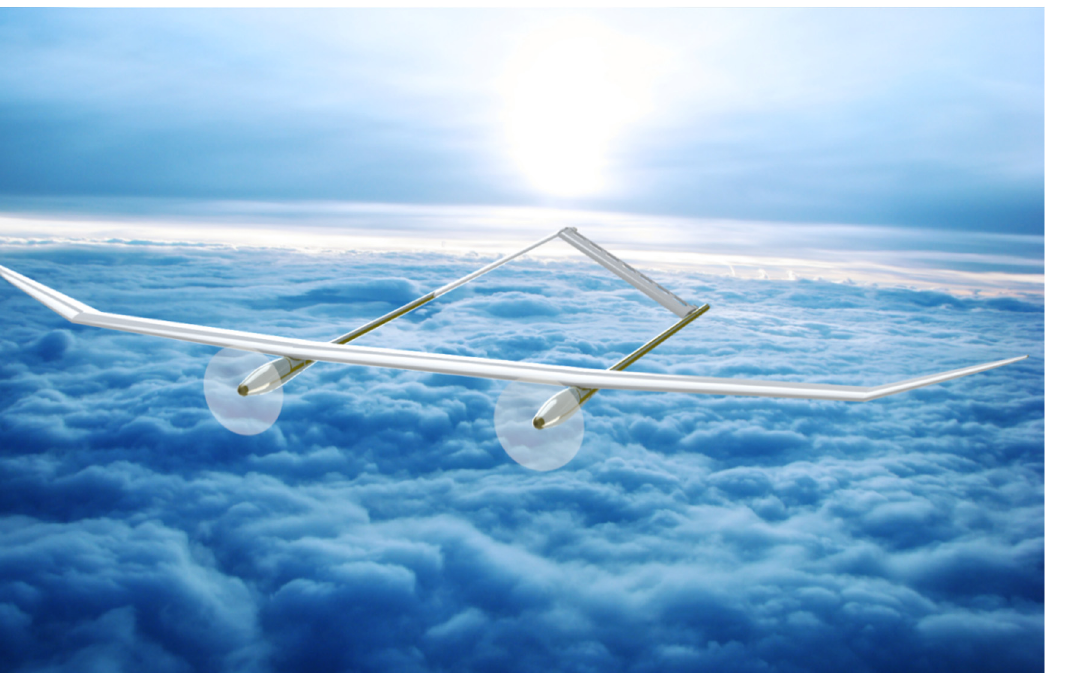
Figure 12. Visualization of the STRATOS unmanned aerial vehicle (UAV).